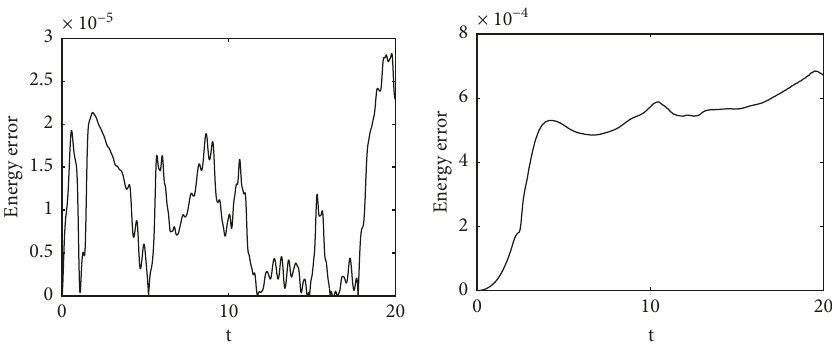
Figure 5: Energy errors for the second-order symplectic method in t